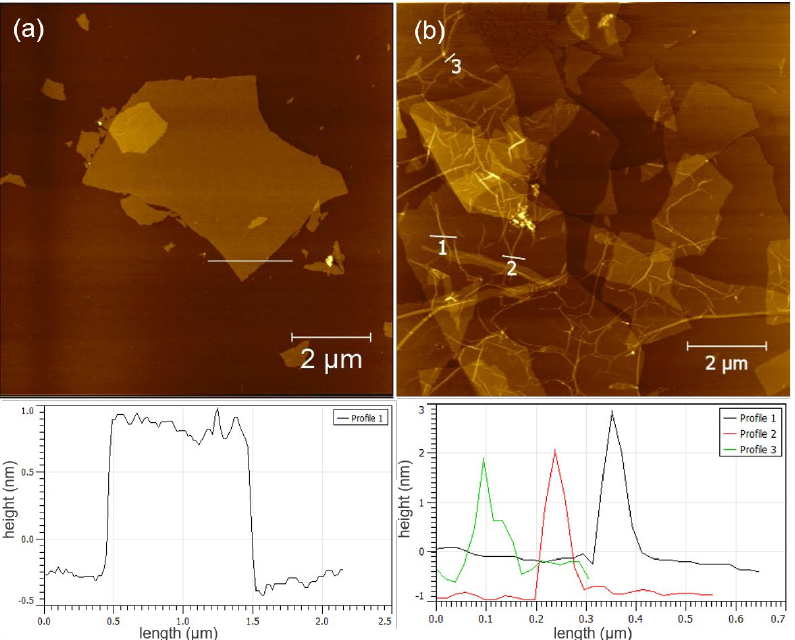
Figure 2. Morphological and structural features of GO and GO/PNFs: ( a ) AFM images and cross- sectional analysis of GO; ( b ) AFM images and cross − sectional analysis of GO/PNFs.